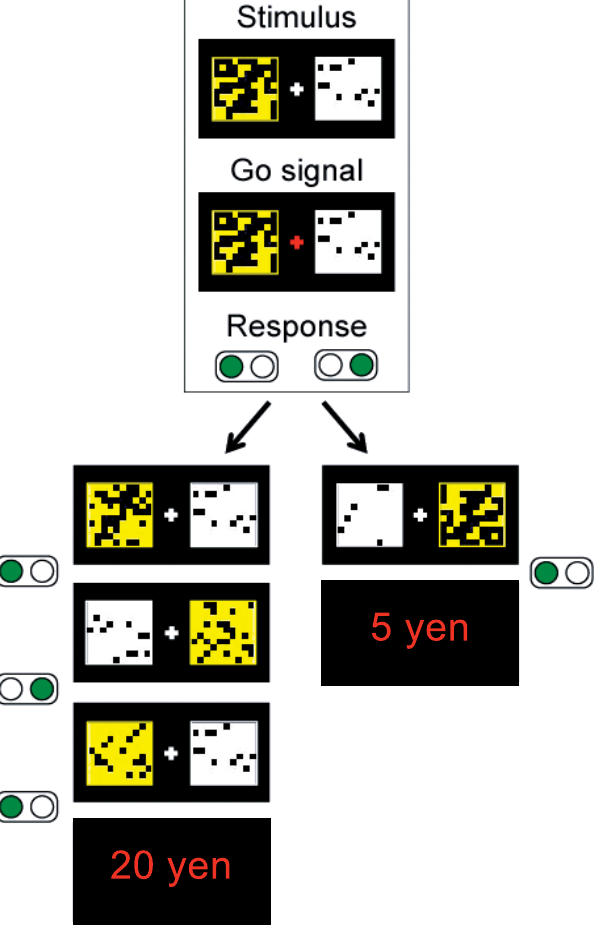
Figure 2. Experimental Task At each trial the subject must select either a white or a yellow